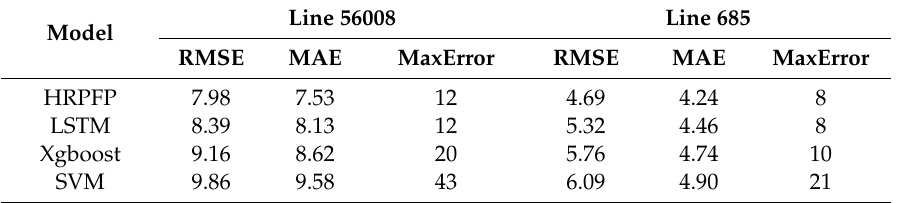
Table 1. Evaluation values of di ff erent models for on-board passenger number prediction. Line 56008 Line 685 Model RMSE MAE MaxError RMSE MAE MaxError